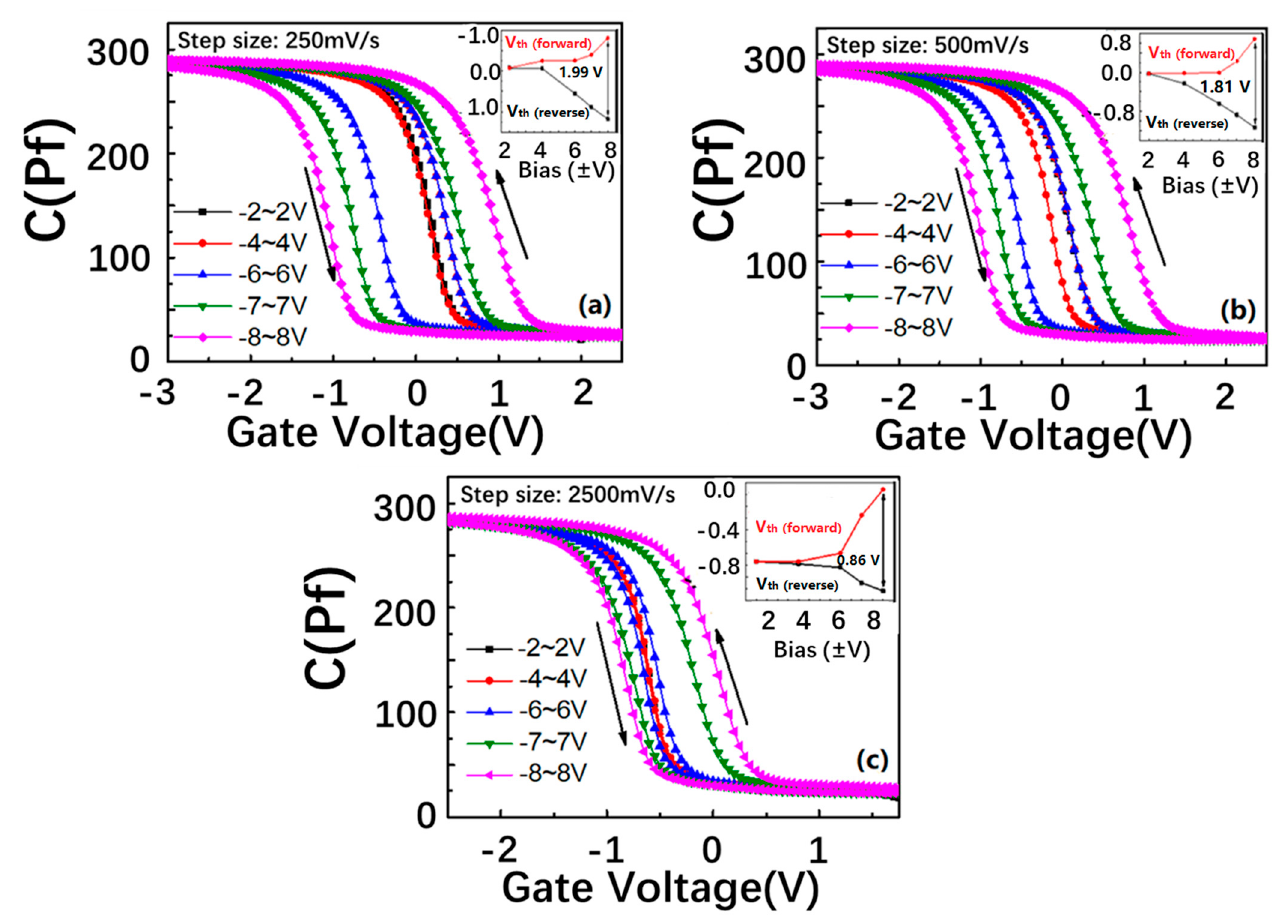
Figure 4. Double C–V sweeps of the fabricated SiN x /nc-Si(a-Si)/SiO 2 floating-gate MOS structure with a thicker nitride SiN x control layer in different scanning bias ranges, and the ramp rates are ( a ) 250 mV/s, ( b ) 500 mV/s, and ( c ) 2500 mV/s, respectively. The insets show the scanning bias range is dependent on the V fb s at different ramp rates.